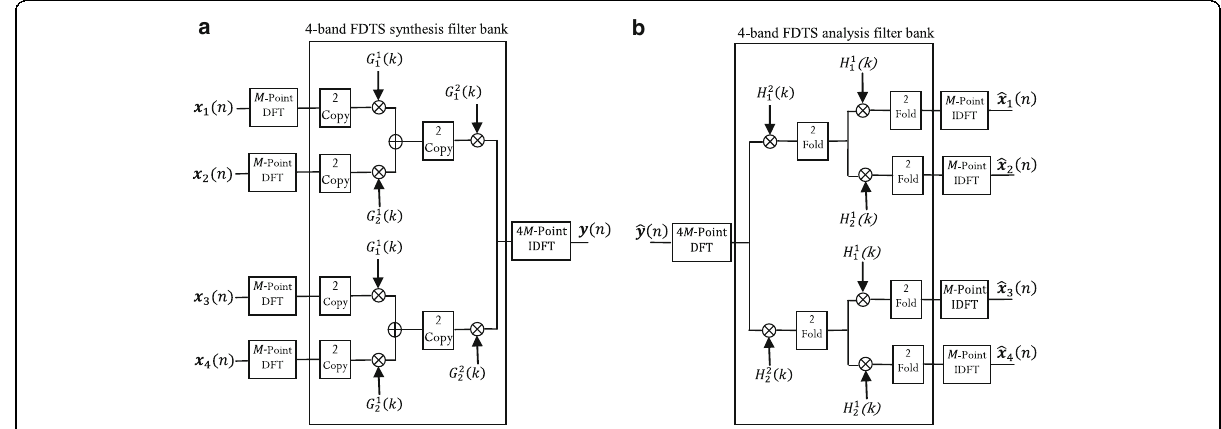
Fig. 5 Frequency domain implementation of 4-band tree-structured filter bank. a Synthesis part. b Analysis